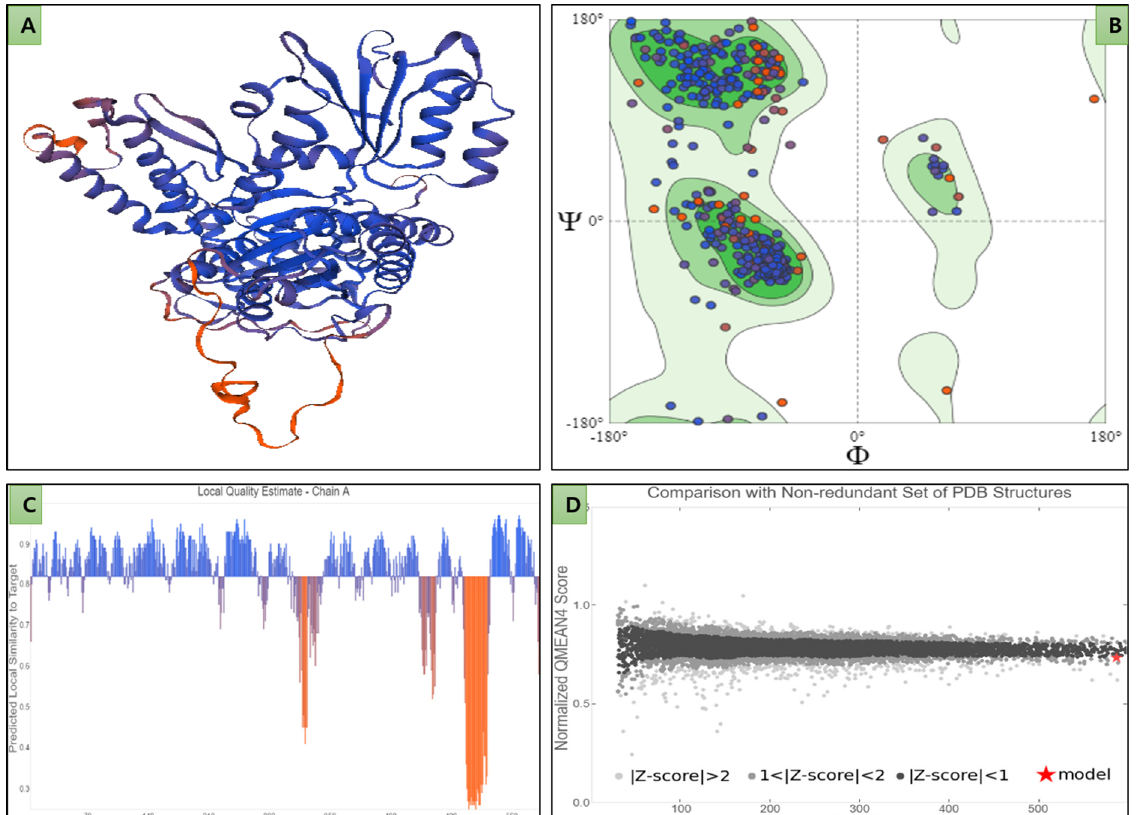
Figure 2. Three-dimensional model and quality assessment of STXBP1. ( A ) Ribbon pattern 3D visualization of 3D STXBP1 model; ( B ) Ramachandran quality assessment plot representing the distribution of peptide residues − phi ( Φ ) and psi ( Ψ ) torsion angle; ( C ) local quality estimation plot; ( D ) representing QMean4 score plot of STXBP1 (non-redundant set of PDB structures ( (cid:70) ) versus total 3D models available in